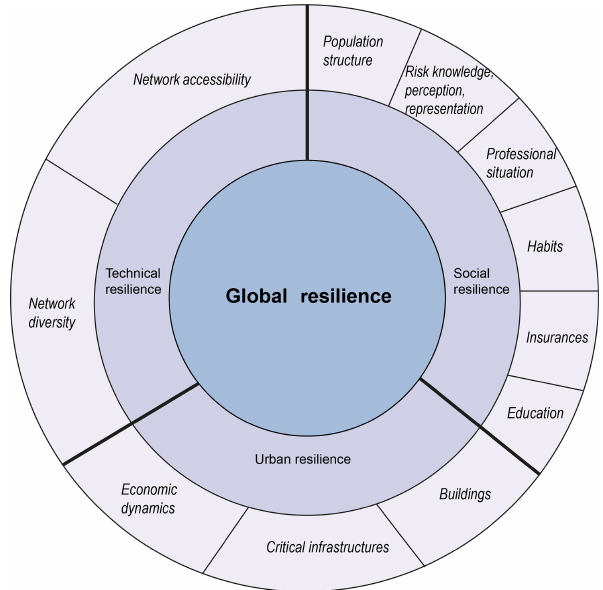
Figure 6. Resilience characteristics (Serre and Heinlef,